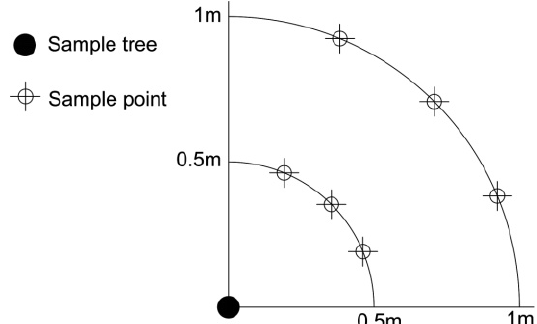
Figure 2. Setting of roots sampling.